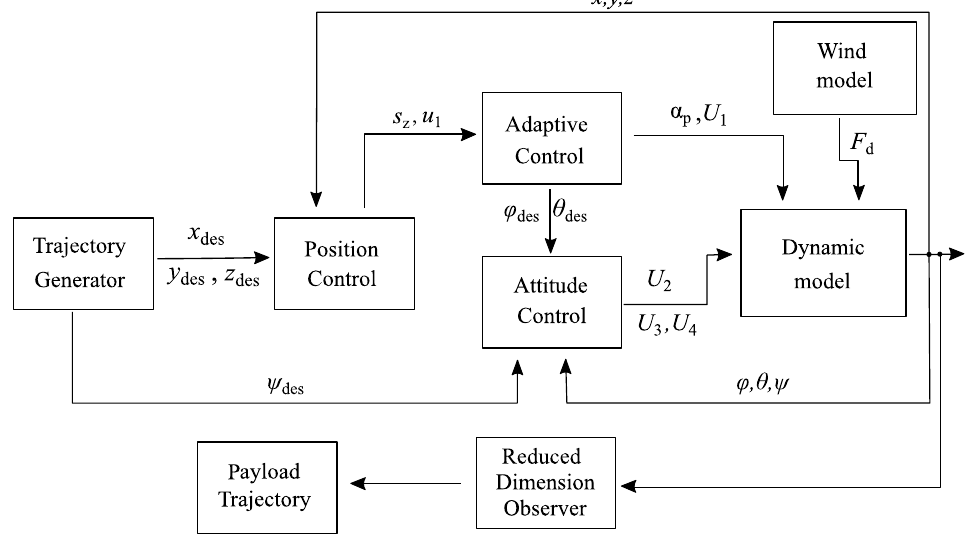
Figure 3. Schematic illustration of the controller design.